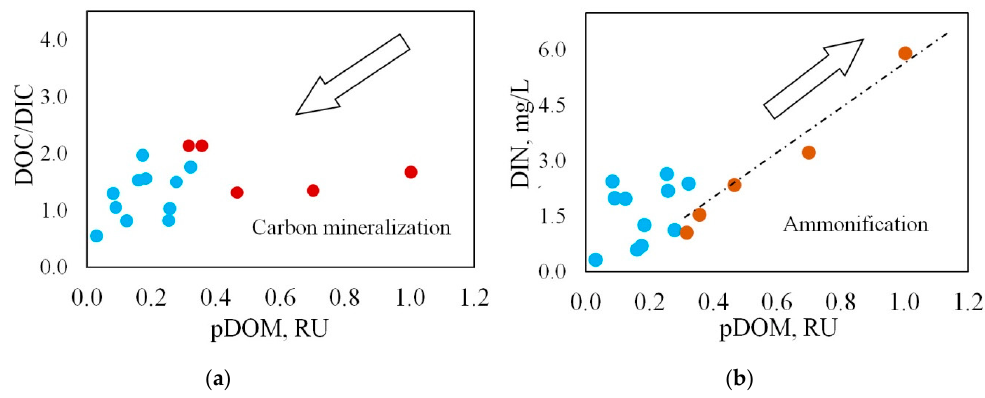
Figure 9. Relationship between protein-like DOM (pDOM) fluorescence intensity and ( a ) DIC/DOC ratio; ( b ) dissolved inorganic nitrogen DIN; arrows indicate the major trends in biogeochemical cycling: DOC mineralization (carbon cycle) and ammonification (nitrogen cycle). Red circles—TGI, blue circles—ice wedges.